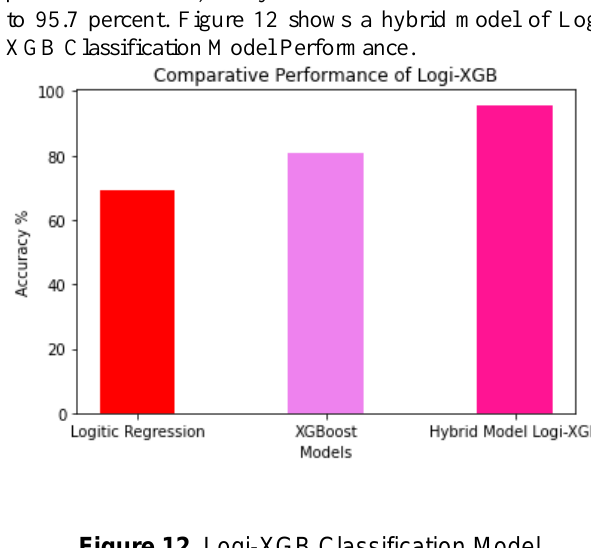
Figure 12. Logi-XGB Classification Model